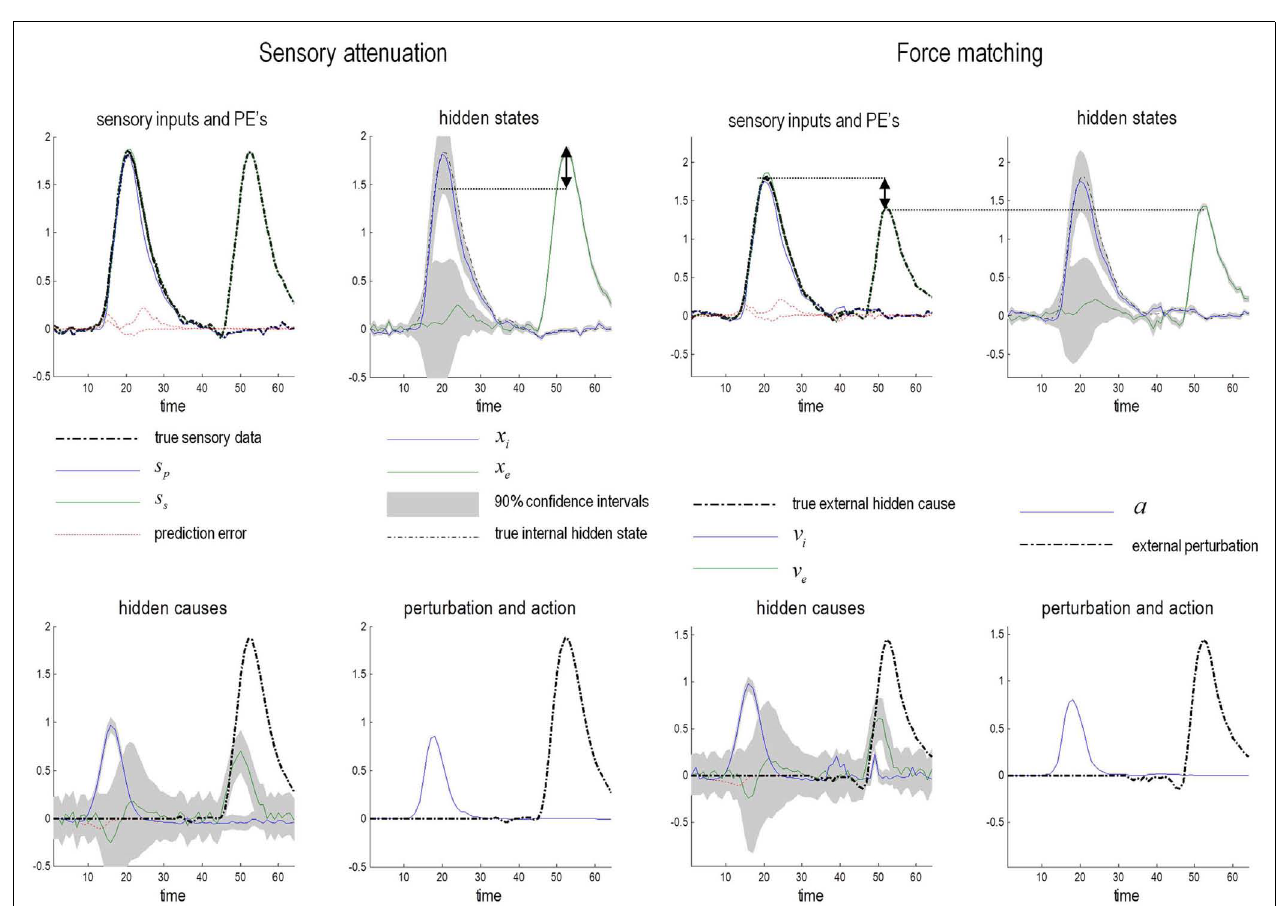
intensity of the sensation is associated with the lower 90% confidence bound of the estimate of hidden state (highlighted by the dotted line), it will be lower when the force is self generated than when the force is exogenous (the difference is highlighted by the arrow). Right panels: the simulation was repeated but the external force was matched to the lower bound of the 90% confidence interval of the internal force.This means that internally generated force is now greater than the externally applied force (double-headed arrow, upper left panel).This reproduces the normal psychophysics of the force-matching illusion that can be regarded as entirely Bayes-optimal, under appropriate levels of